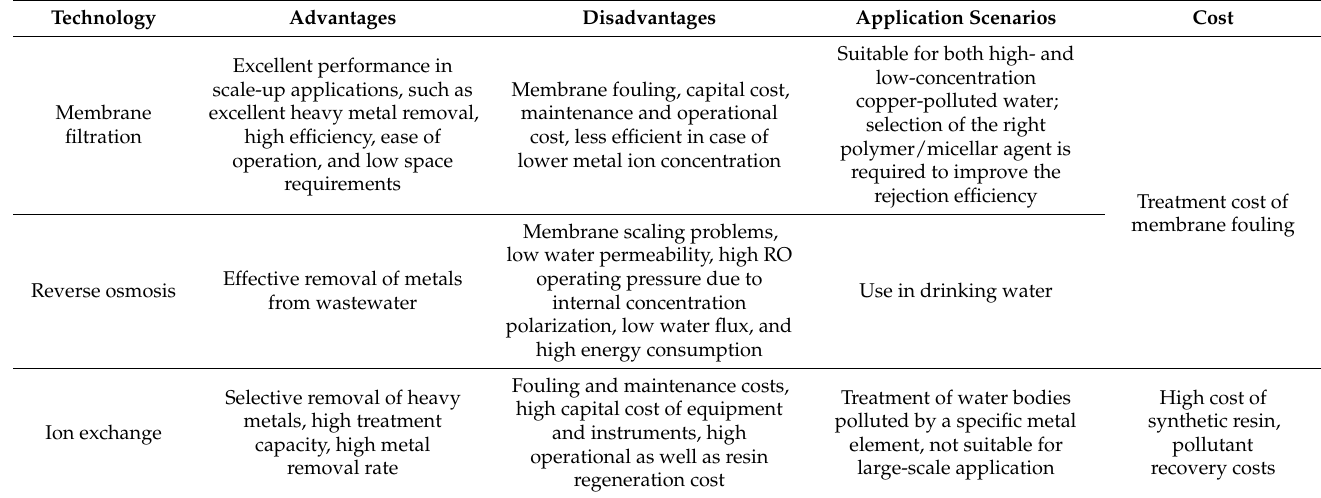
Table 3. Summary of different copper ion removal technologies